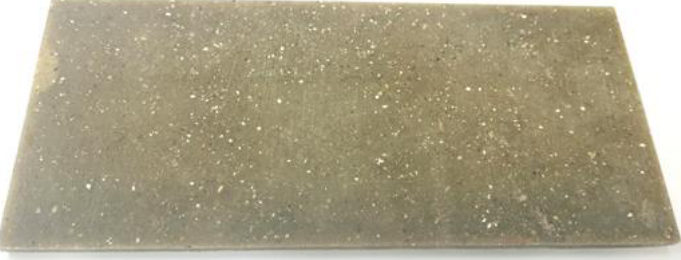
Figure 1. The sample prepared for hardness tests, R10, dimensions 300 × 100.